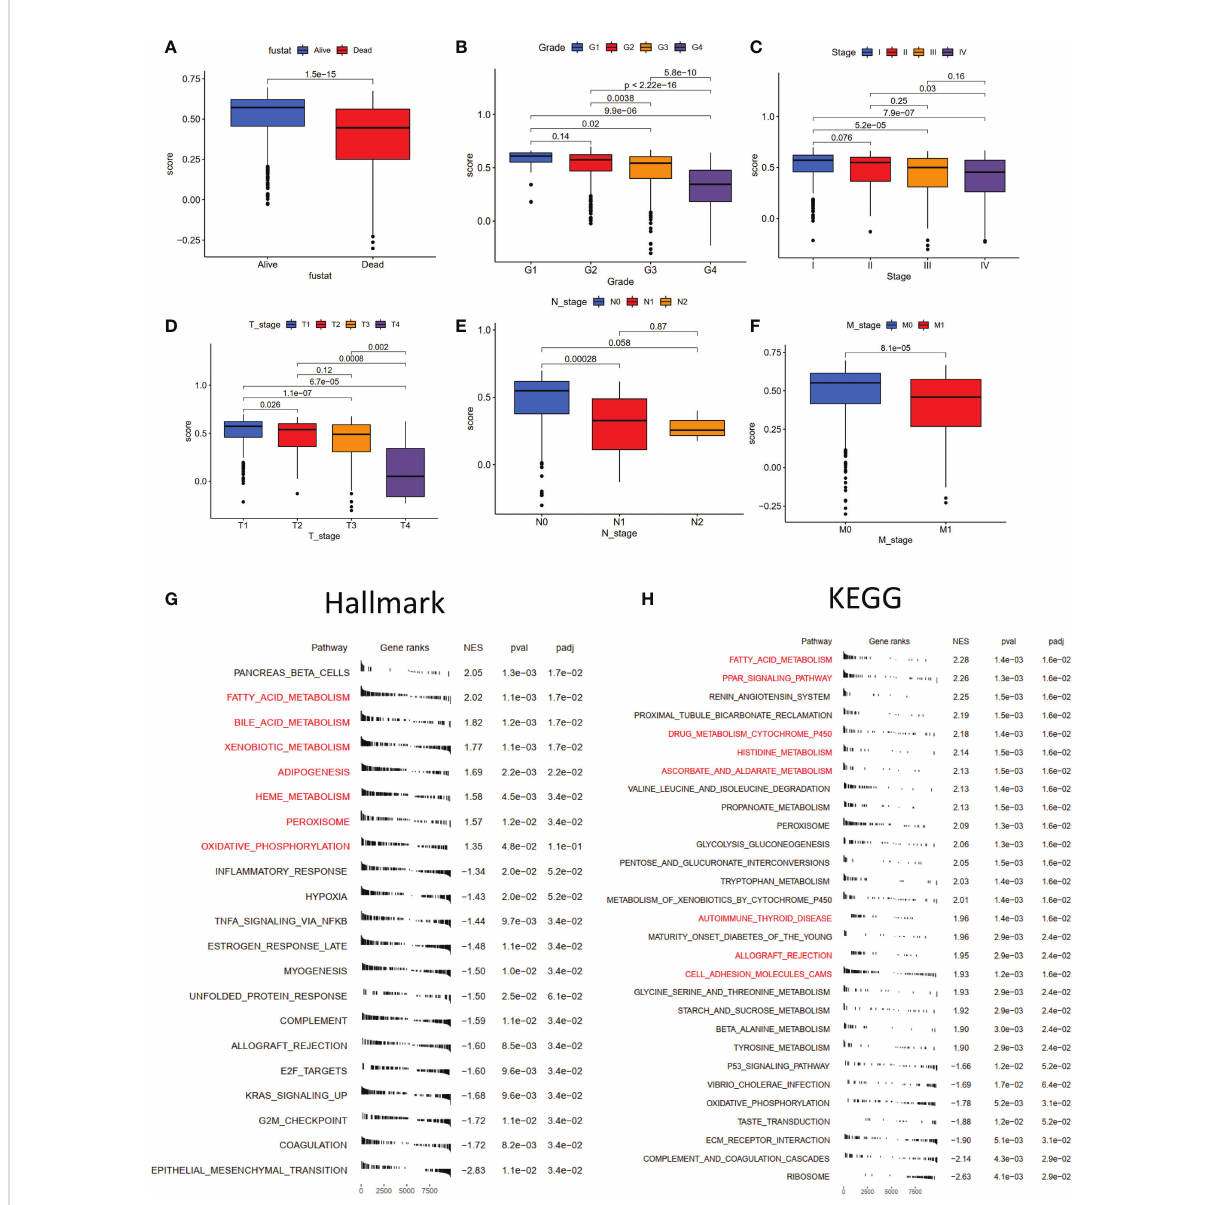
FIGURE 6 The correlation of NET-scores with clinic-pathological characteristics, hallmark and KEGG enrichment between high- and low-NET-score groups. The boxplot of different survival status (A) , clinical grade (B) , clinical stage (C) , tumor stage (D) , regional lymph node status (E) , and distant metastasis (F) . The hallmark (G) and (H) KEGG enrichment between high- and low-NET-score